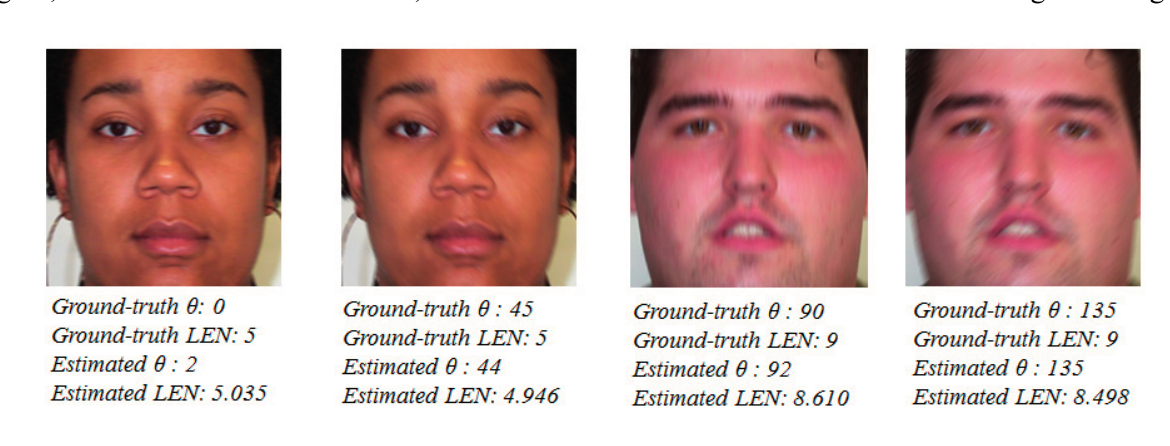
Figure 17. Examples of estimation results of motion blur